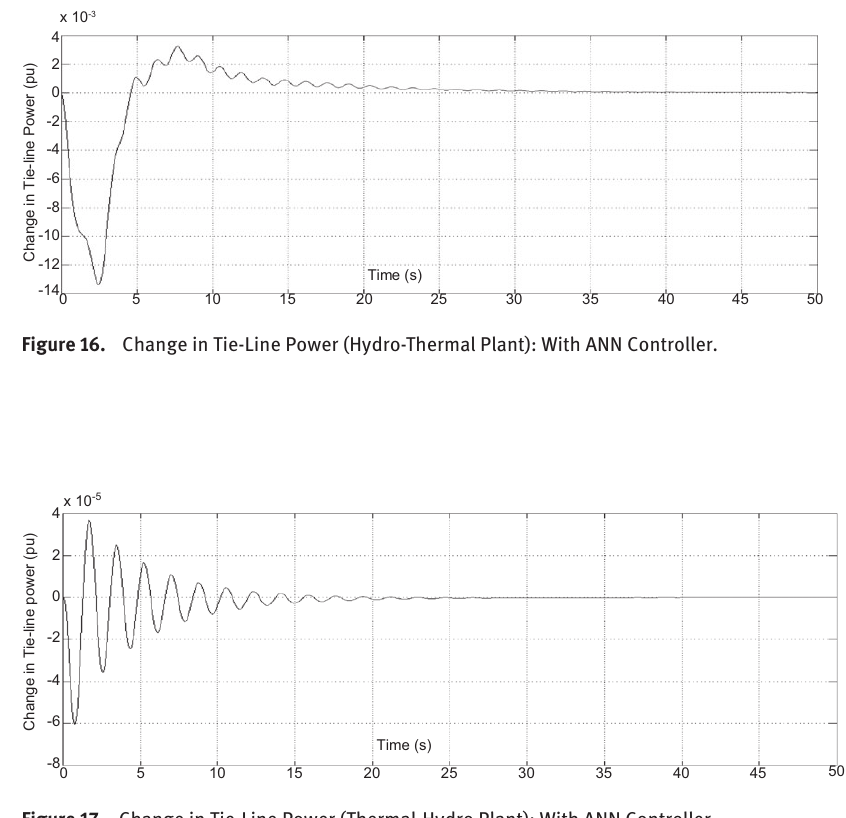
Figure 17. Change in Tie-Line Power (Thermal-Hydro Plant): With ANN Controller.